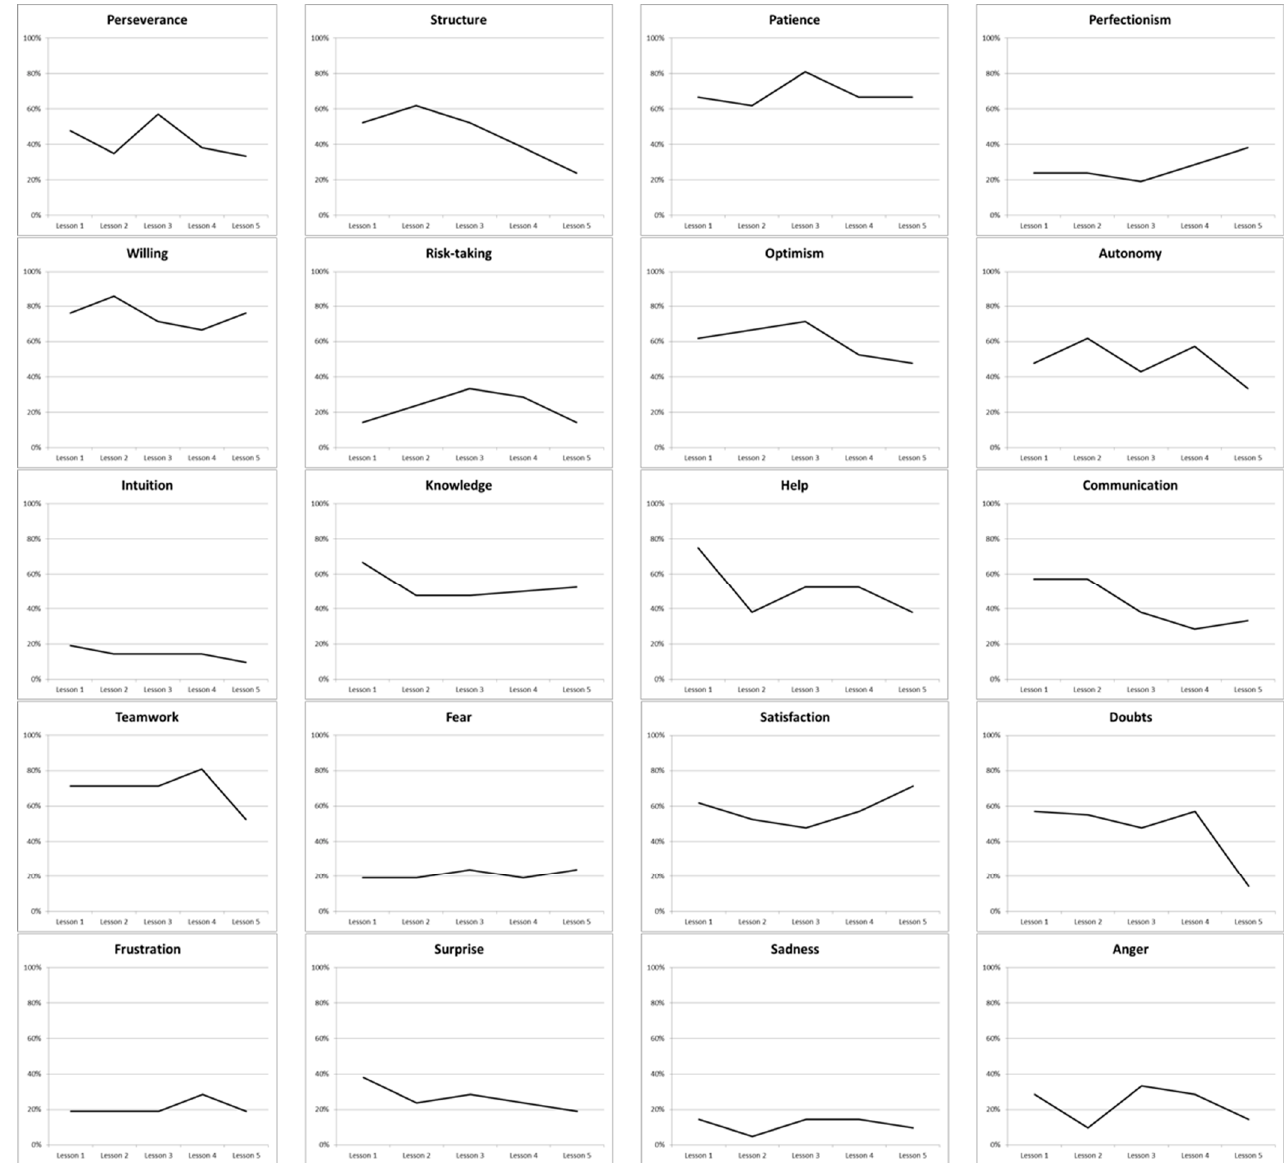
Figure 4. The multivariate factors involved in the creative process during the 5 lessons of the foun- tain